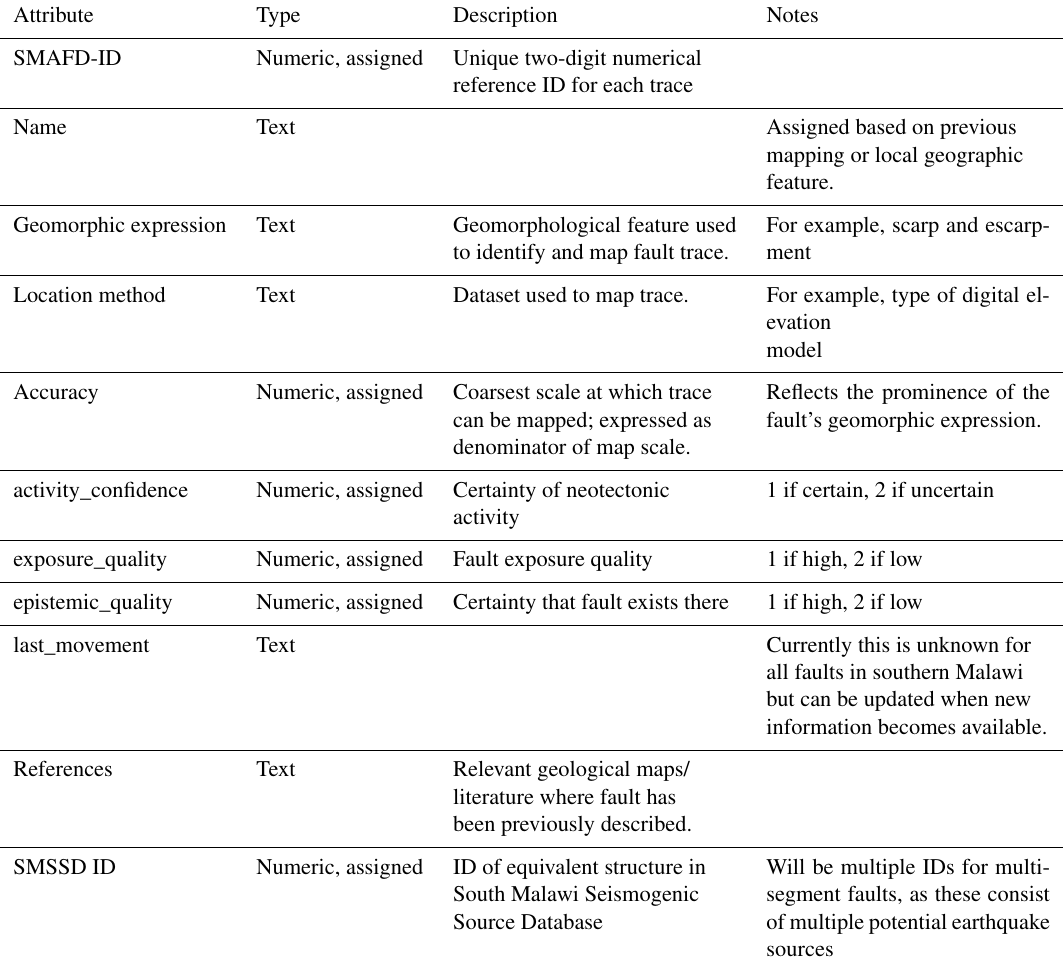
Table 1. List and brief description of attributes in the SMAFD. Attributes are based on the Global Earthquake Model Global Active Faults Database (Styron and Pagani,